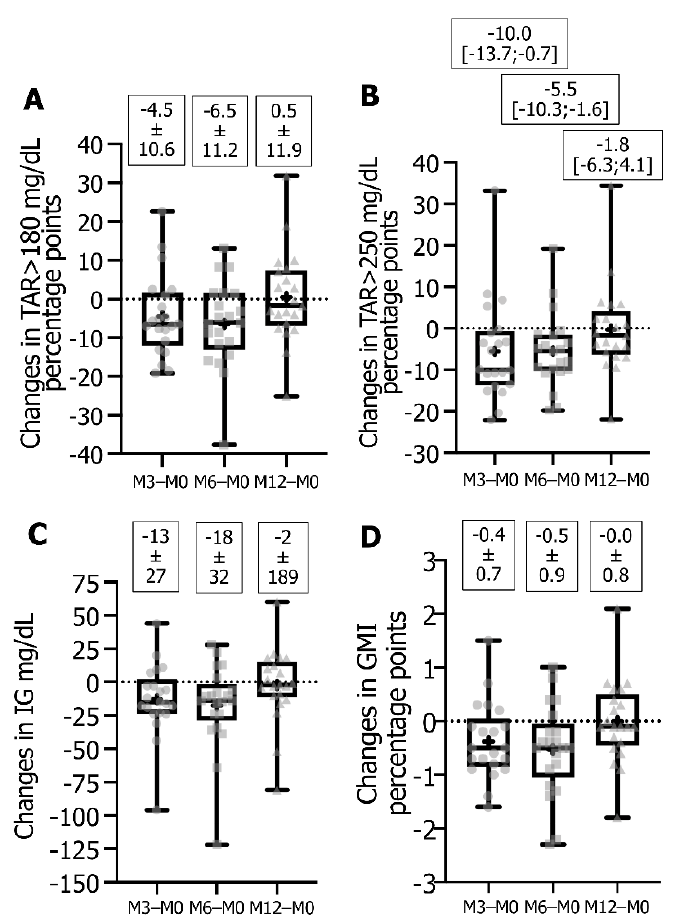
Figure 3. Box-and-whisker plot of changes in TAR > 180 mg/dL ( A ), TAR > 250 mg/dL ( B ), average IG concentration mg/dL ( C ) and GMI % ( D ). Data represented as plots are median, first quartile (Q1 or 25th percentile) and third quartile (Q3 or 75th percentile), min and max, mean (as a cross) and all individual points for changes calculated from DG4 parameter at M3 or M6 or M12 − FSL1 parameters expressed as percentage points except for average IG concentration which is in mg/dL. Values indicated are means ± SD or median [Q1;Q3]. Data are from 21 T1D followed-up patients. Ab- breviations: DG4, Dexcom platinum G4; FSL1, FreeStyle Libre version 1; GMI, glucose management indicator; IG, interstitial glucose; TAR, time-above-range.